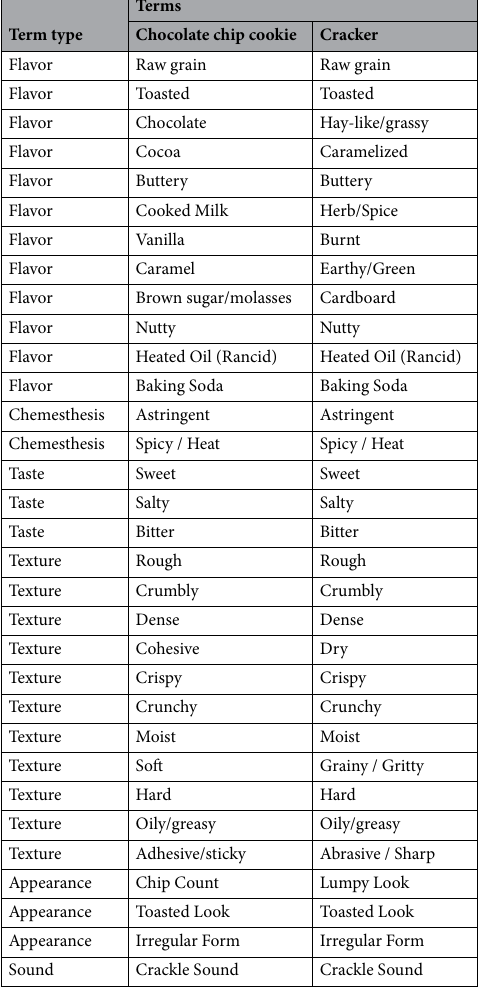
Table 1. List of term types and associated terms for products